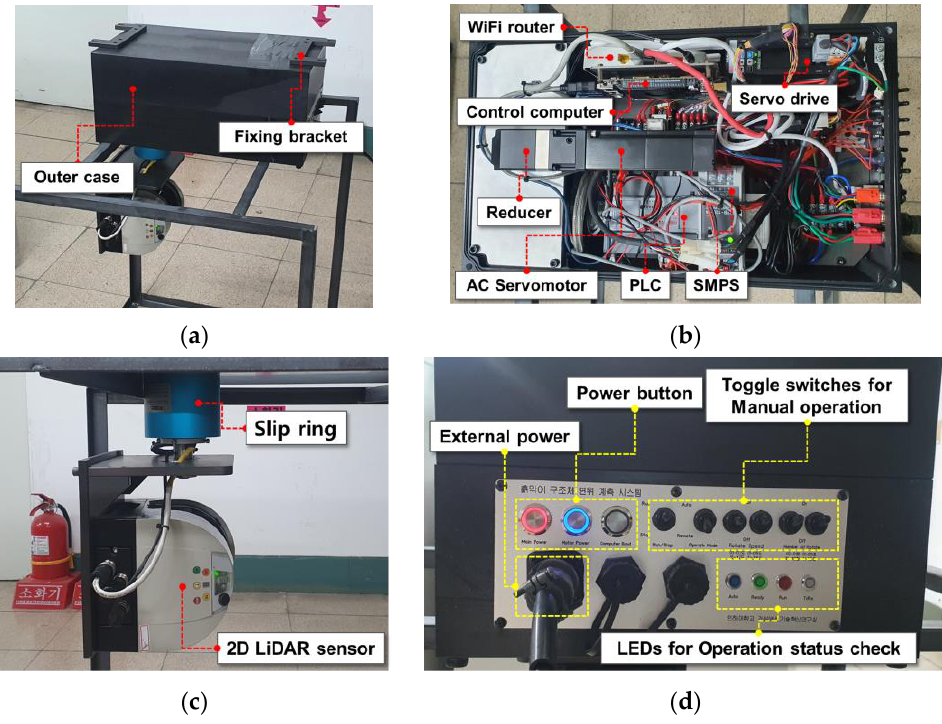
Figure 6. Retaining wall displacement measurement hardware. ( a ) Perspective view; ( b ) inside the hardware; ( c ) 2D LiDAR sensor and slip ring; ( d ) control panel.